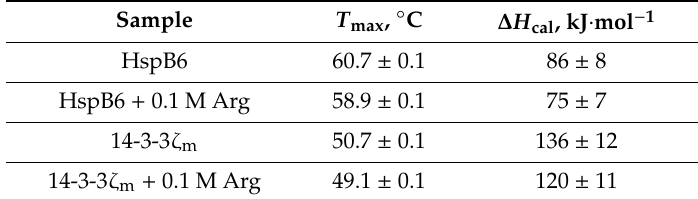
Table 2. Calorimetric parameters obtained from the DSC data for the thermal transitions of protein chaperones in the absence and in the presence of 0.1 M